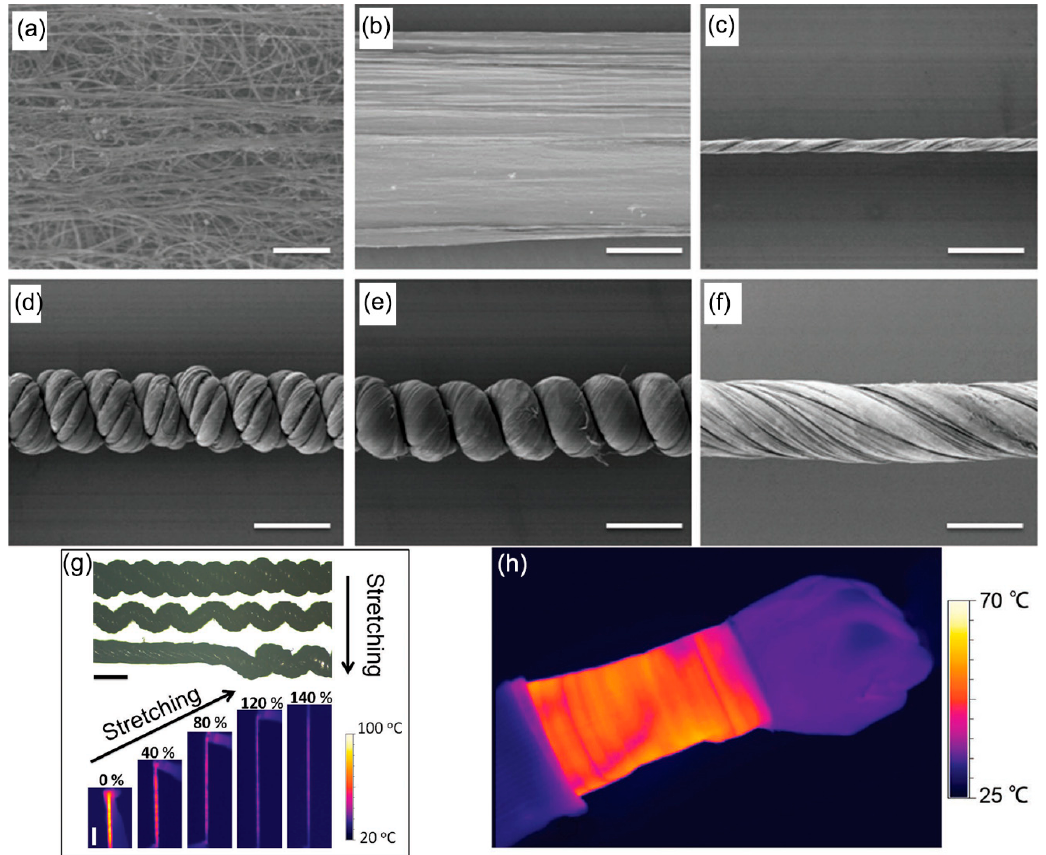
Figure 15. Scanning electron microscope (SEM) images of CNT ribbons at ( a ) high and ( b ) low magnifications, respectively, ( c ) SEM images of primary CNT fiber, ( d – f ) SEM images of HHF, single-ply spring-like fiber, and single-ply nonspring-like fiber with the same diameter. Scale bars: 1 μ m in ( a ) and 200 μ m in ( b − f ). ( g ) Optical images and infrared images during stretching. Scale bars: 200 μ m (top) and 1 cm (bottom). ( h ) Infrared image of the heating textile wrapped on the wrist at 9 V. Scale bar: 2.5 cm. Reproduced from Ref. [130] with permission. Copyright 2017, John Wiley and Sons.